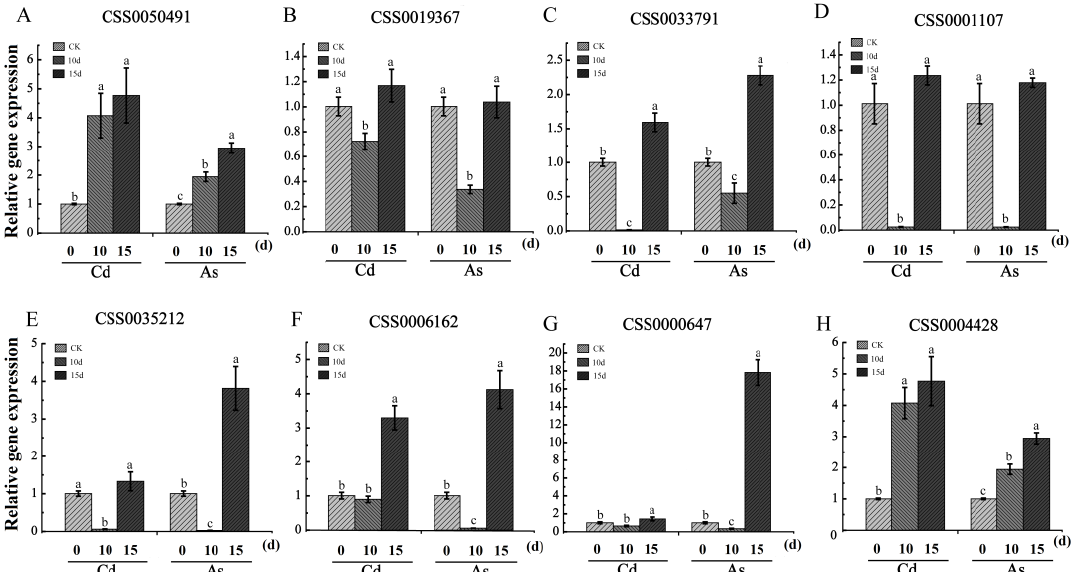
Figure 8. Validation of the expression patterns of eight candidate DEGs in Cd/As-treated tea roots. ( A – H ) The relative expression levels of candidate genes relative to CsGAPDH was measured by qRT-PCR. ( A ) The relative expression levels of CSS0050491 under Cd/As stress; ( B ) The relative expression levels of CSS0019367 under Cd/As stress; ( C ) The relative expression levels of CSS0033791 under Cd/As stress; ( D ) The relative expression levels of CSS0001107 under Cd/As stress; ( E ) The relative expression levels of CSS0035212 under Cd/As stress; ( F ) The relative expression levels of CSS0006162 under Cd/As stress; ( G ) The relative expression levels of CSS0000647 under Cd/As stress; ( H ) The relative expression levels of CSS0004428 under Cd/As stress. Three technical and biological replicates were used for each data point. Data were presented as means ± Sd ( N = 3). Different letters above bars indicate significant differences between the Cd-treated tea roots and the control group ( p < 0.05).